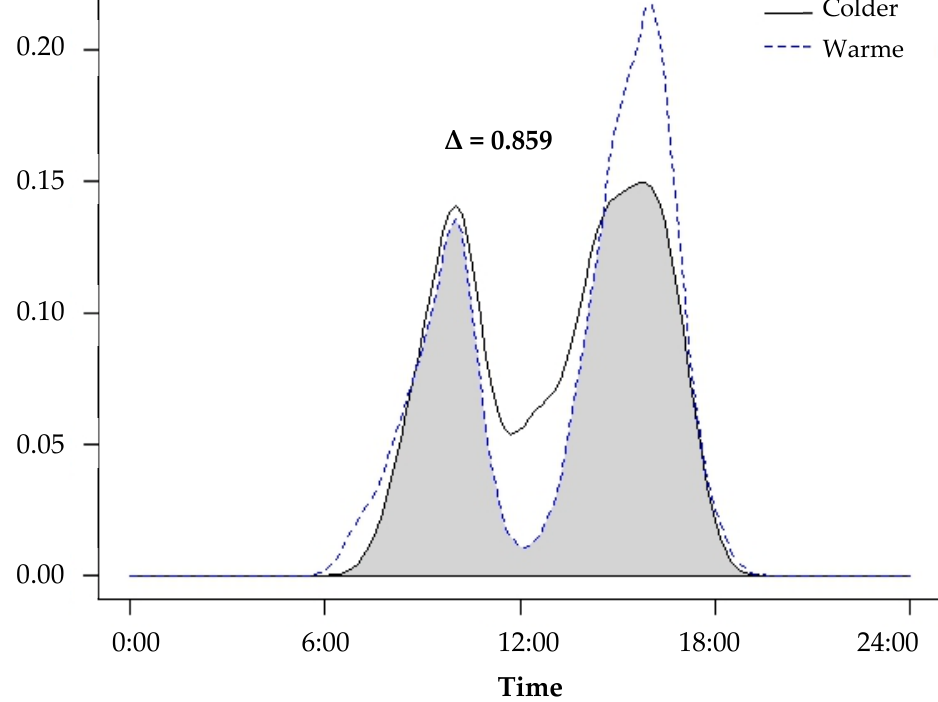
Figure 2. The activity patterns of yellow mongooses during the colder seasons (autumn and winter; solid line) and warmer seasons (spring and summer; dotted line) in the Meyersdal estate. The overlap coefficient between the periods ( Δ ) equals the area below both curves shaded grey in this figure, expressing seasonal overlap and variation in activity patterns.